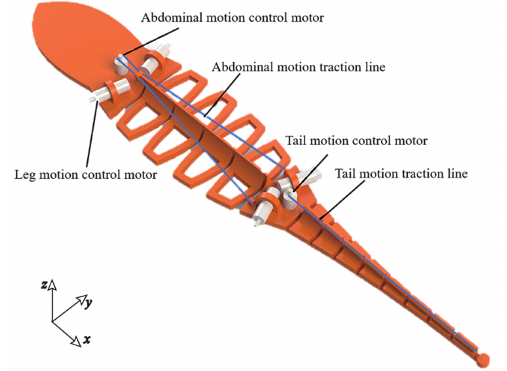
Figure 9. Simplified model of the